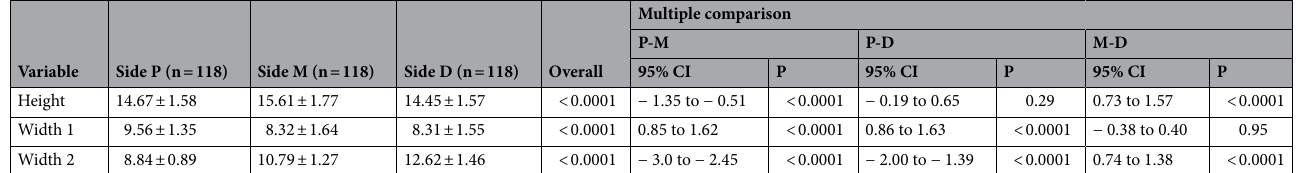
Table 3. The height and width of each section of the fibula.